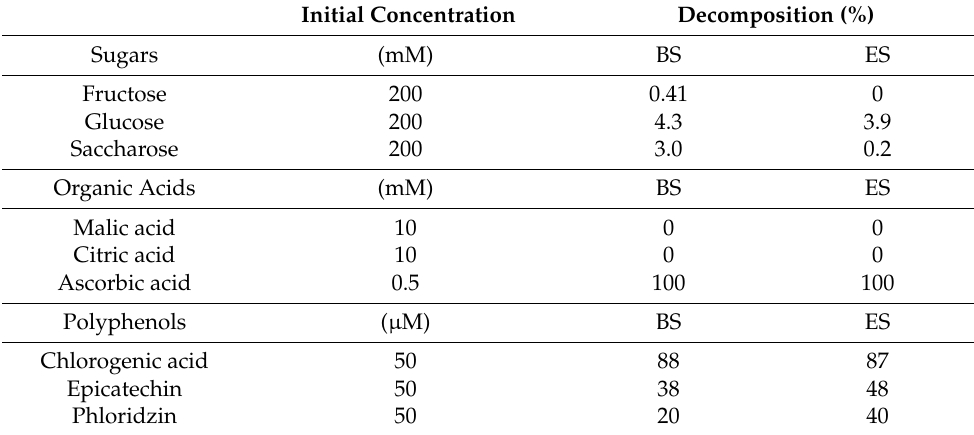
Table 3. Decomposition rate of single juice components (sugars, organic acids, polyphenols) after their individual plasma treatments (solutions with the given initial concentration were prepared